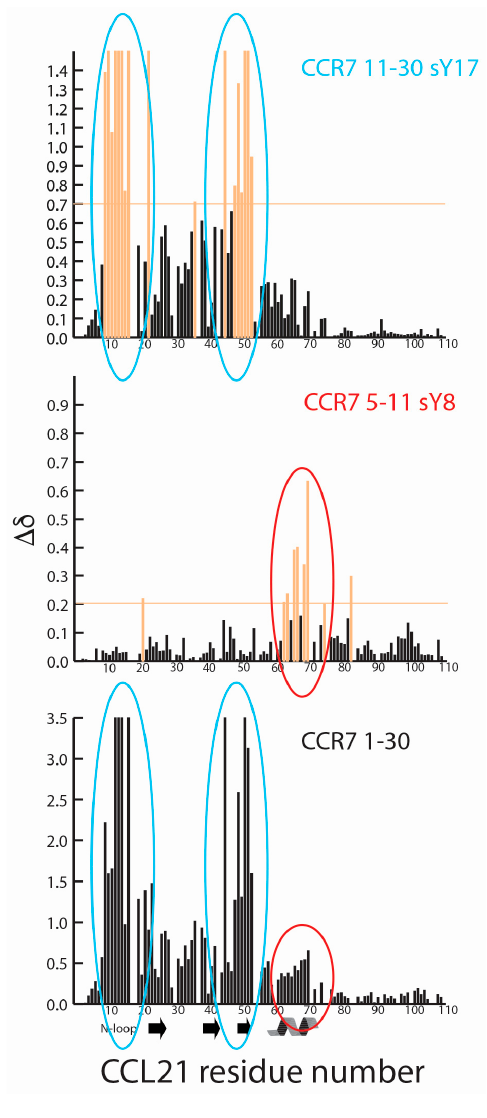
Figure 5. CCR7 site 1 is potentially modular with respect to CCL21 binding. CCL21 chemical shift perturbations are shown for CCR7 11–30 sY17 (top), CCR7 5–11 sY8 (middle), and CCR7 1–30 (bottom), adapted from Love et al. [41]. For CCR7 11–30 sY17 and CCR7 1–30, residues whose signal broadens beyond detection during titration are indicated with the highest chemical shift perturbation value. CCR7 11–30 sY17 and other CCR7 11–30 peptides induce chemical shift perturbations in the N-loop and β 3 strand (circled in blue) with similar perturbations observed for CCR7 1–30, as indicated by blue ovals. CCR7 5–11 sY8 and other CCR7 5–11 peptides induce chemical shift perturbations in CCL21’s α -helix with potentially similar perturbations observed for CCR7 1–30, as indicated with the red ovals.